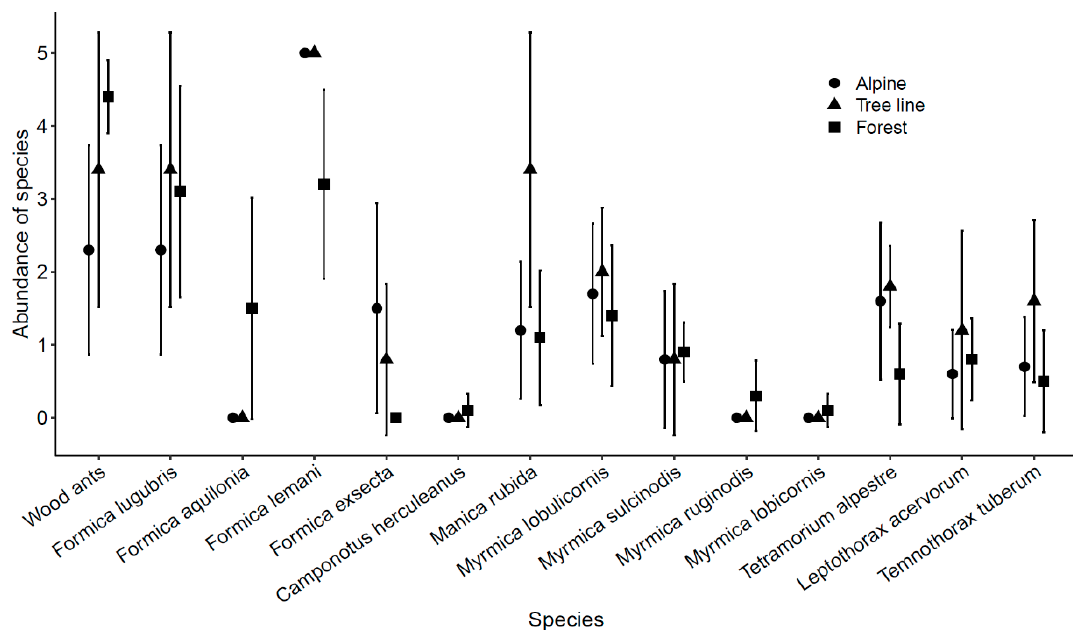
Figure 2. Mean pseudo-abundance of ant species with 95% confidence intervals split among the three habitat types. The maximum possible abundance score was five, only reached on average by Formica lemani in alpine grassland and on the tree line. The sum of pseudo-abundances of all mound-building wood ants together (comprising F. lugubris and F. aquilonia ) was included to visualize the overall prevalence of these two ant species which otherwise tend to exclude each other locally.